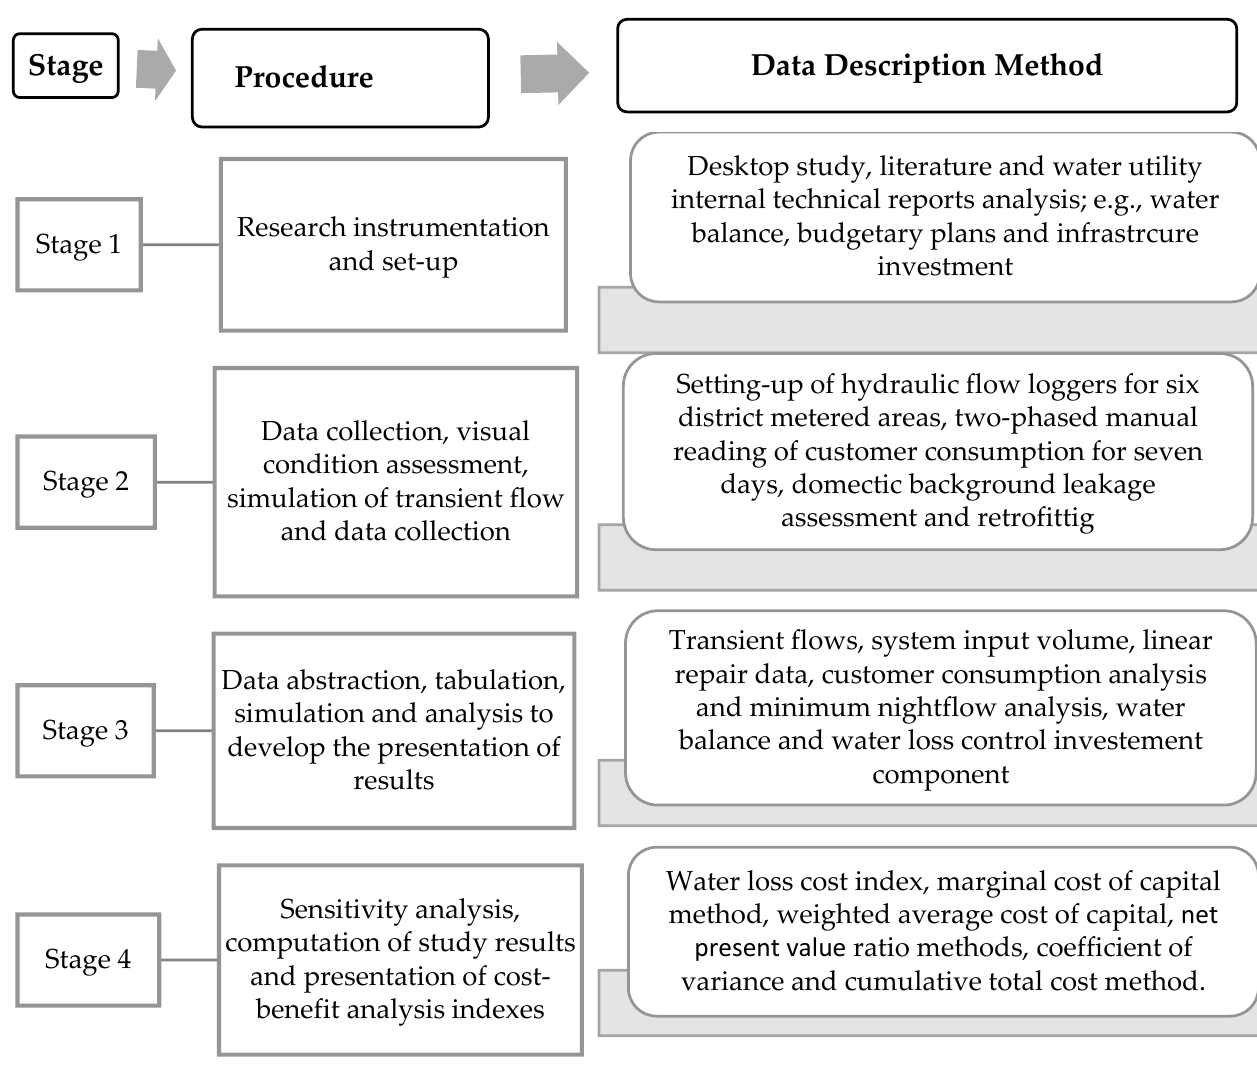
Figure 1. Process flow diagram